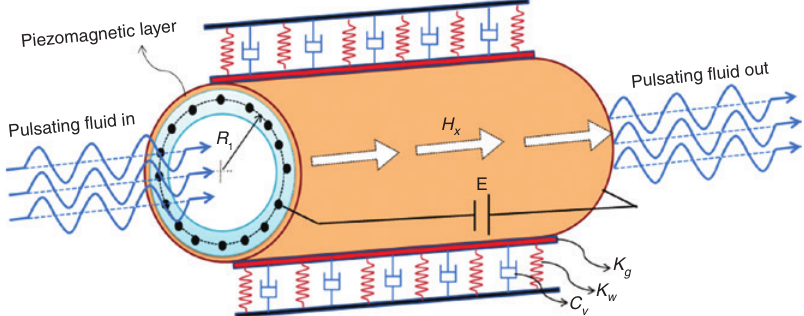
Figure 1: A schematic diagram of a double-layered shell modeled embedded in a viscoelastic